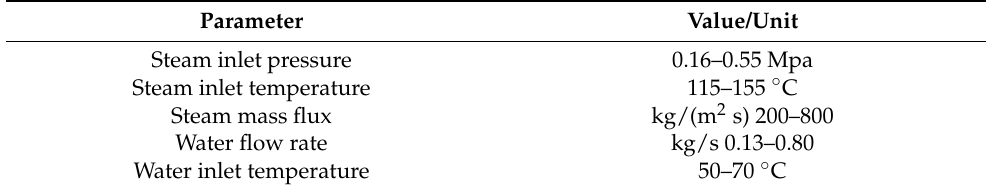
Table 11. The test conditions during experiments of Chen et al. [47].